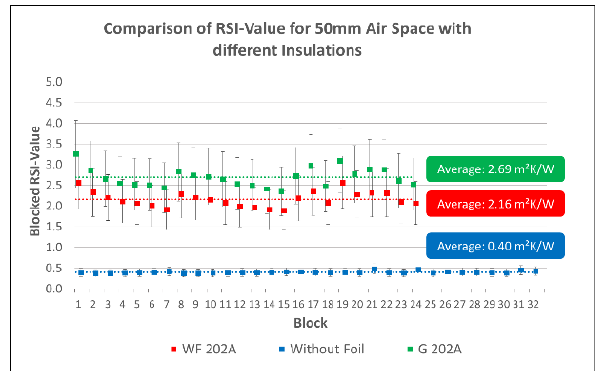
Figure 11: Comparison of temperatures